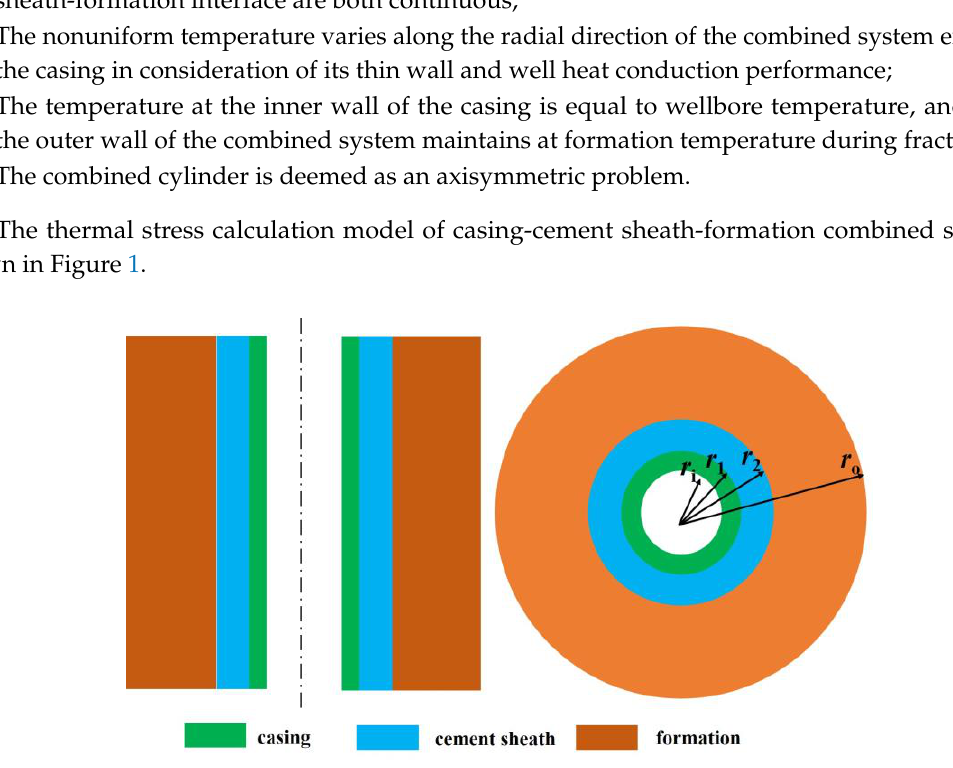
Figure 1. Thermal stress calculation model of casing-cement sheath-formation combined system.